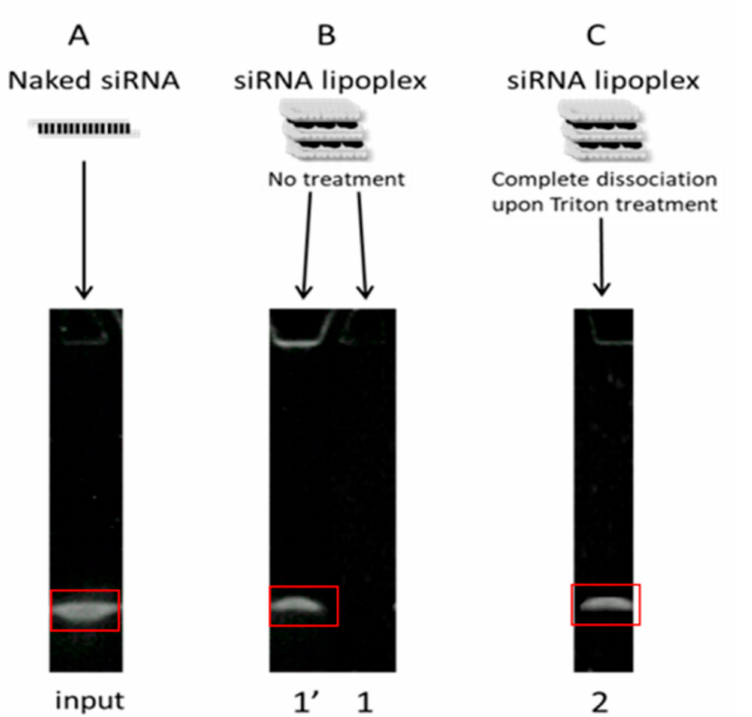
Figure 2. Diagram of siRNA integrity analysis on acrylamide gel. ( A ) When analyzed by gel electrophoresis, intact, naked, double-stranded siRNA appeared as a band. ( B ) siRNA lipoplexes were loaded on acrylamide gels, (1) if all the siRNAs were complexed in the assayed lipoplexes, no band was detected, (1 (cid:48) ) whereas a band was detected if some of the siRNA payload leaked out. ( C ) Treatment of siRNA lipoplexes with Triton X-100 completely dissociated particles, releasing their siRNA payload (2). Band intensity (from the intact band) was then quantified with Image J. A red rectangular selection area was selected to measure the raw integrated density of each band. Results were expressed relative to naked